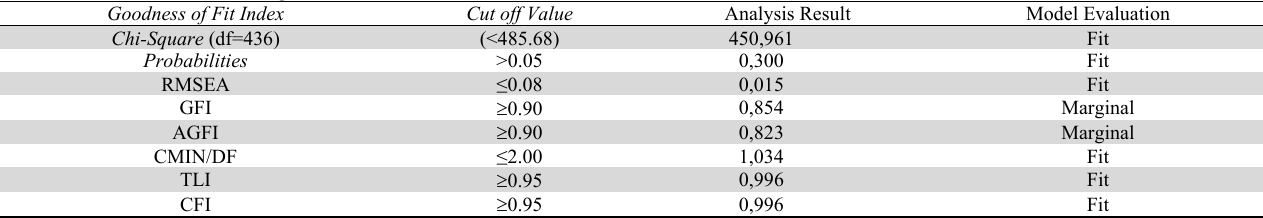
Result of Full Model Testing